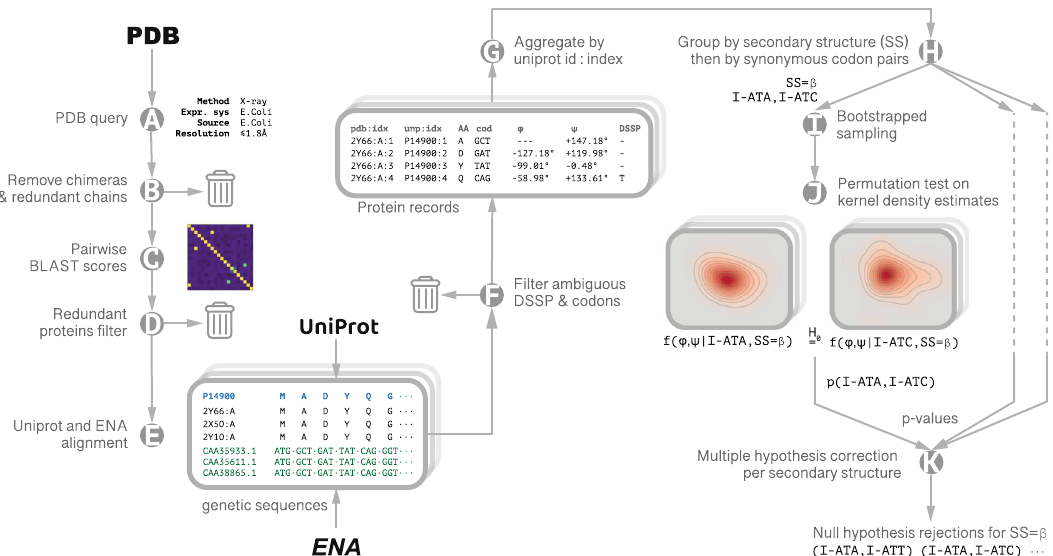
Fig. 1 Data Collection and Analysis. Querying the PDB for high resolution ( ≤ 1.8 Å), high quality ( R free ≤ 24%) X-ray crystal structures of E. coli proteins expressed in E. coli ( A ), out of which unique chains were extracted ( B ). To ensure the protein set was non-redundant, pairwise sequence alignment scores were calculated between every pair of unique sequences ( C ). A farthest point sampling procedure was then employed to produce a sub-set of structures with normalized pairwise similarity not exceeding 0.7 ( D ). Structures were then grouped according to their unique Uniprot identi fi er. Genetic sequences were retrieved from ENA records cross-referenced by Uniprot ( E ), adopting a conservative approach: locations having more than one genetic variant for a speci fi c residue are excluded from further analysis ( F ). For each group, a single protein record was generated with each point in the amino acid sequence annotated with the φ , ψ backbone dihedral angles averaged over all the structures in the record, the codon, and DSSP secondary structure assignment ( G ). The fi nal data set included 1343 protein chains. We estimated the codon distributions from their samples using kernel density estimation (KDE) on a torus with a Gaussian kernel width of 2°. We used a bootstrap-resampling scheme to estimate multiple realizations of these codon speci fi c distributions. p-values were calculated via permutation test on the L 1 distance between the estimated densities (steps H – J ); the rejection threshold ( p = 0.019) was established by Benjamini-Hochberg multiple hypothesis correction with the false discovery rate set to q = 0.05 ( K